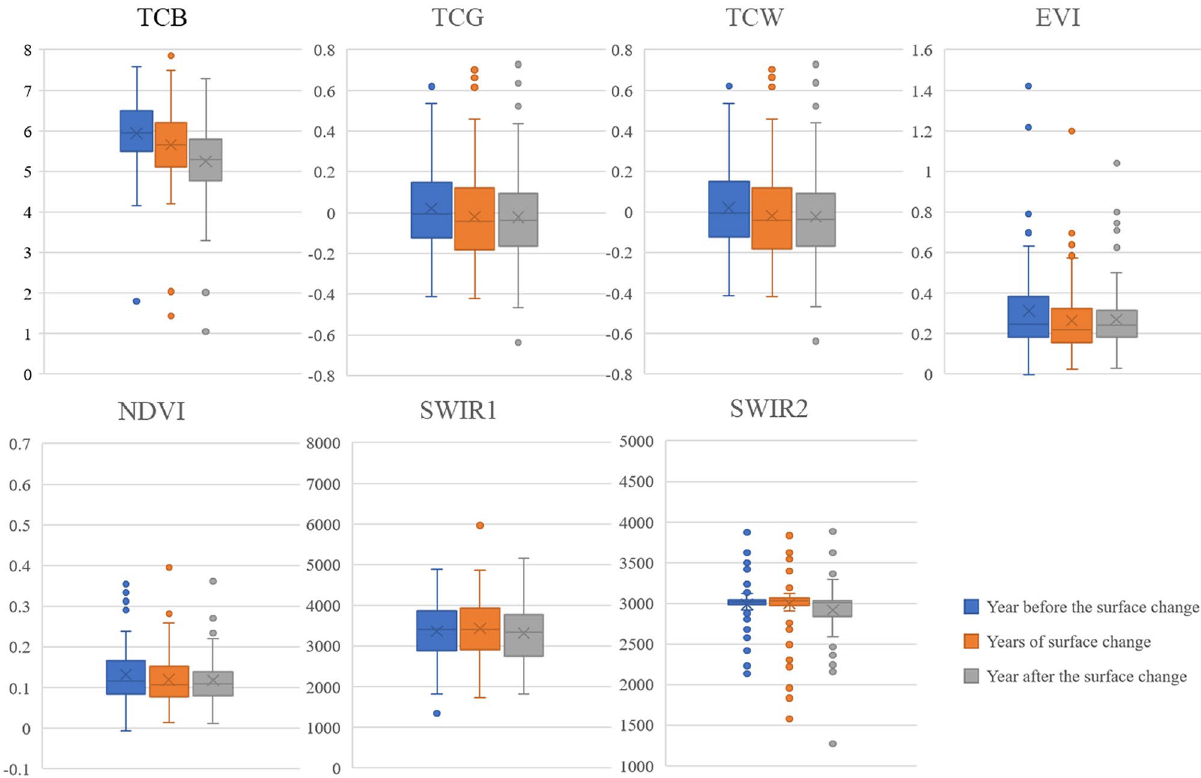
Figure 12. Numerical variation of different bands/indices before, during, and after the disturbance in the built-up